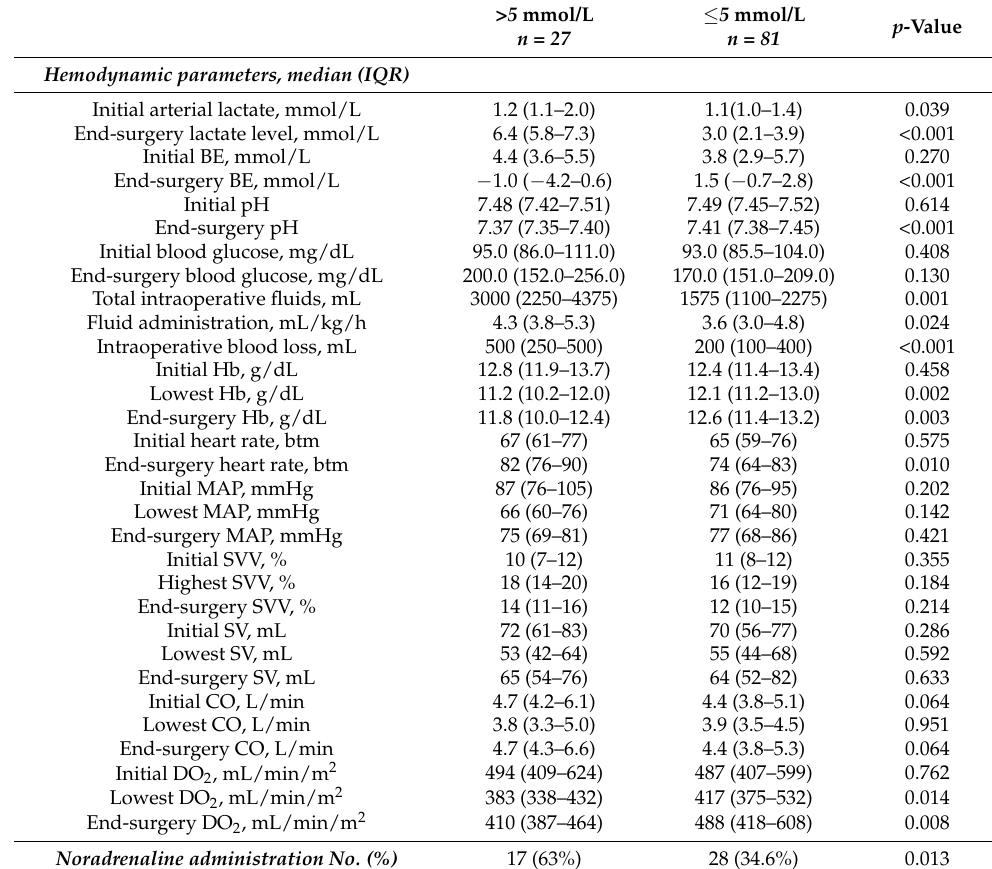
Table 4. Biochemical, fluid balance, and hemodynamic parameters according to end-surgery arterial lactate concentration.